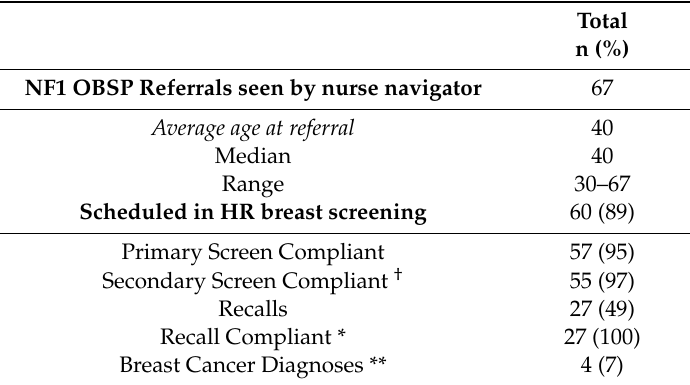
Table 2. High-risk OBSP screening uptake by women diagnosed with NF1.